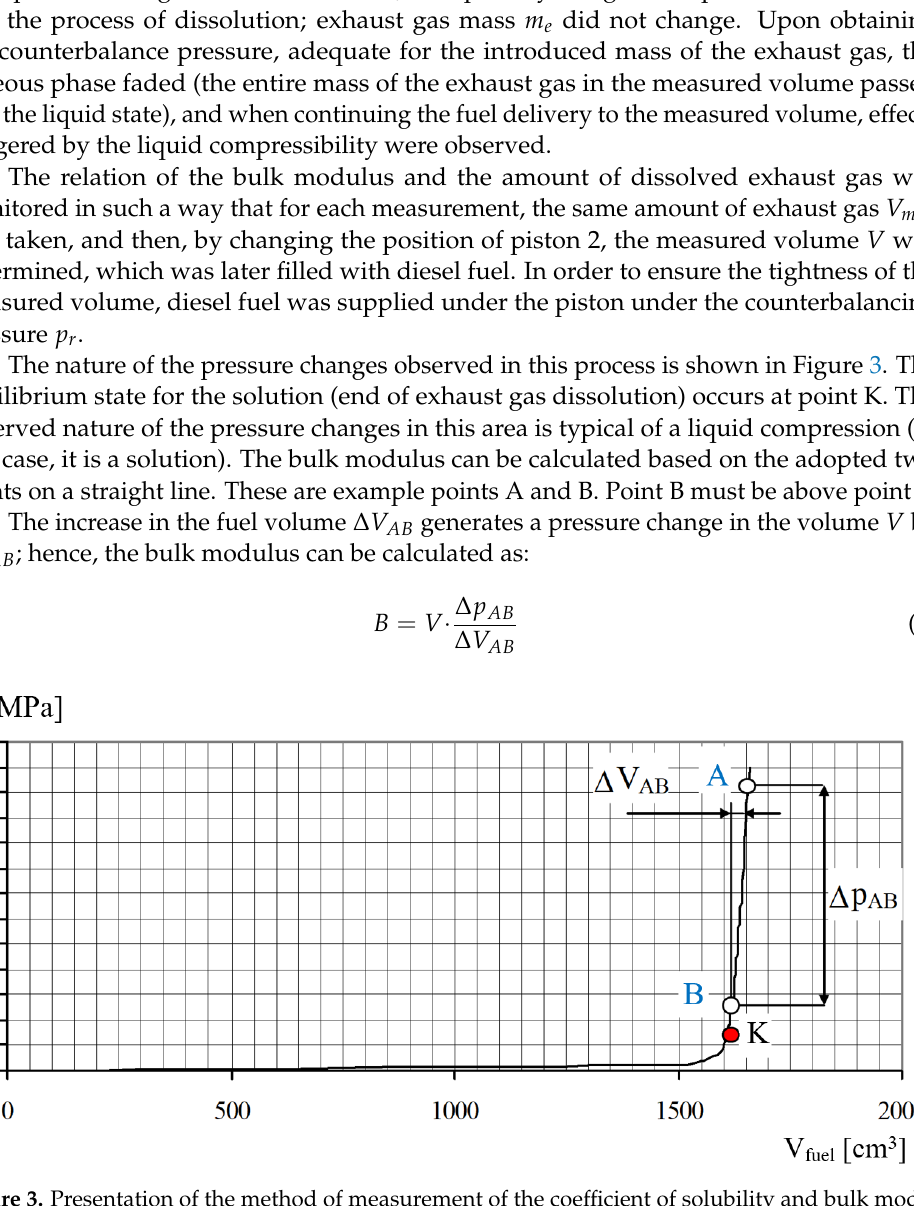
Figure 3. Presentation of the method of measurement of the coefficient of solubility and bulk modulus B of the solution of diesel fuel and exhaust gas: A—measurement end point, B—measurement start point, K—end of exhaust gas dissolution, ∆ p AB —change in pressure on the AB portion, ∆ V AB —change in volume on the AB